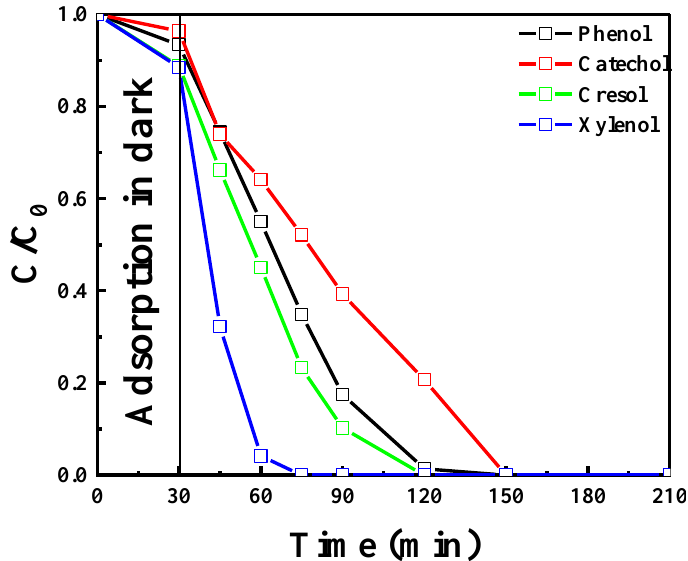
Figure 12. Degradation profile of ( a ) individual pollutants (20 ppm) and ( b ) a mixture of 20 ppm of each pollutant; C 0 = 20 ppm, airflow = 50 mL/min, catalyst = 0.5 g/L, pH = natural, light source = LEDs, Catalyst = exfoliated g-C 3 N 4 .